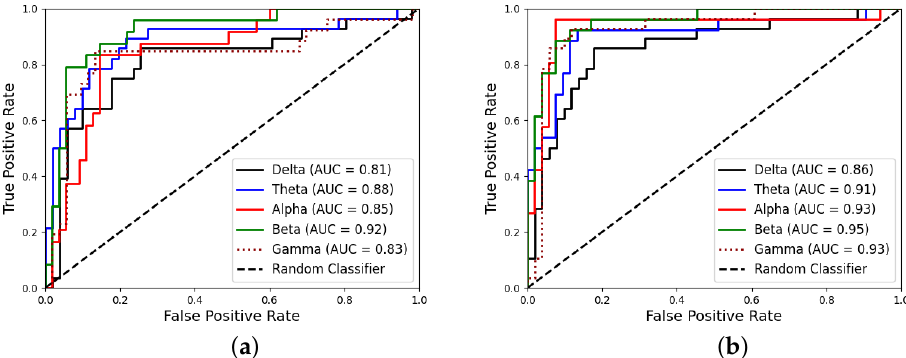
Figure 7. ROC Curves corresponding to the classification results for ( a ) 4.8 Hz and ( b ) 16 Hz